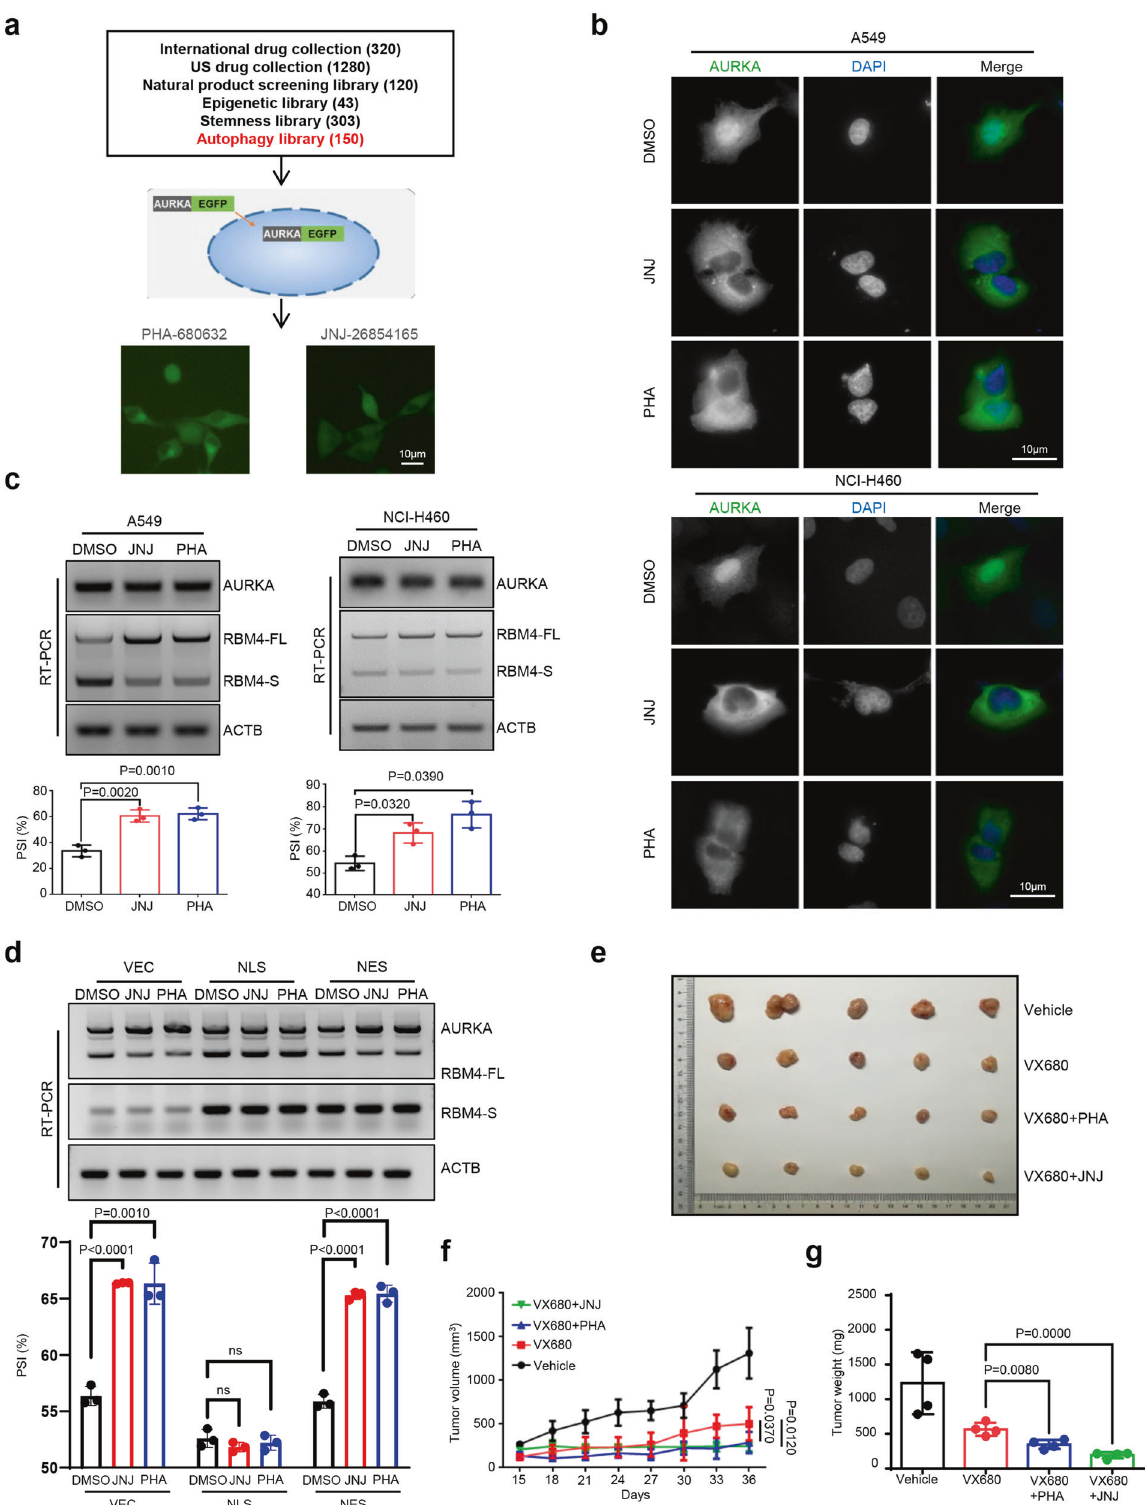
tumor growth both in vitro and in vivo (Fig. 2b – e, Supplementary Fig. S4a – c). Previous reports demonstrate that RBM4 facilitates tumor suppression via not only controlling target pre-mRNA alternative splicing (e.g. Bcl-x and TEAD4) but also through antagonizing oncogenic SRSF1 to inhibit mTOR activation. 19,45